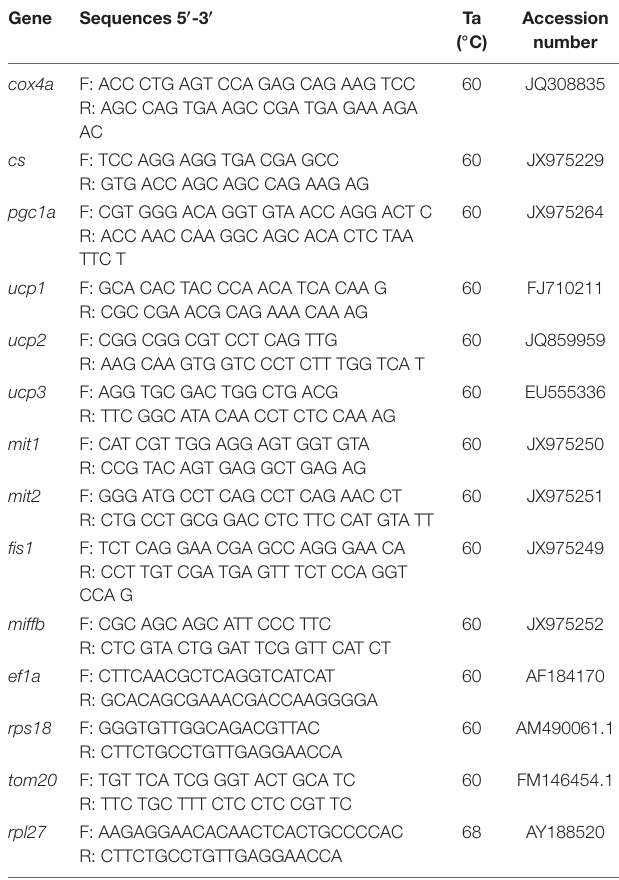
TABLE 2 | Primers used for real-time quantitative PCR.